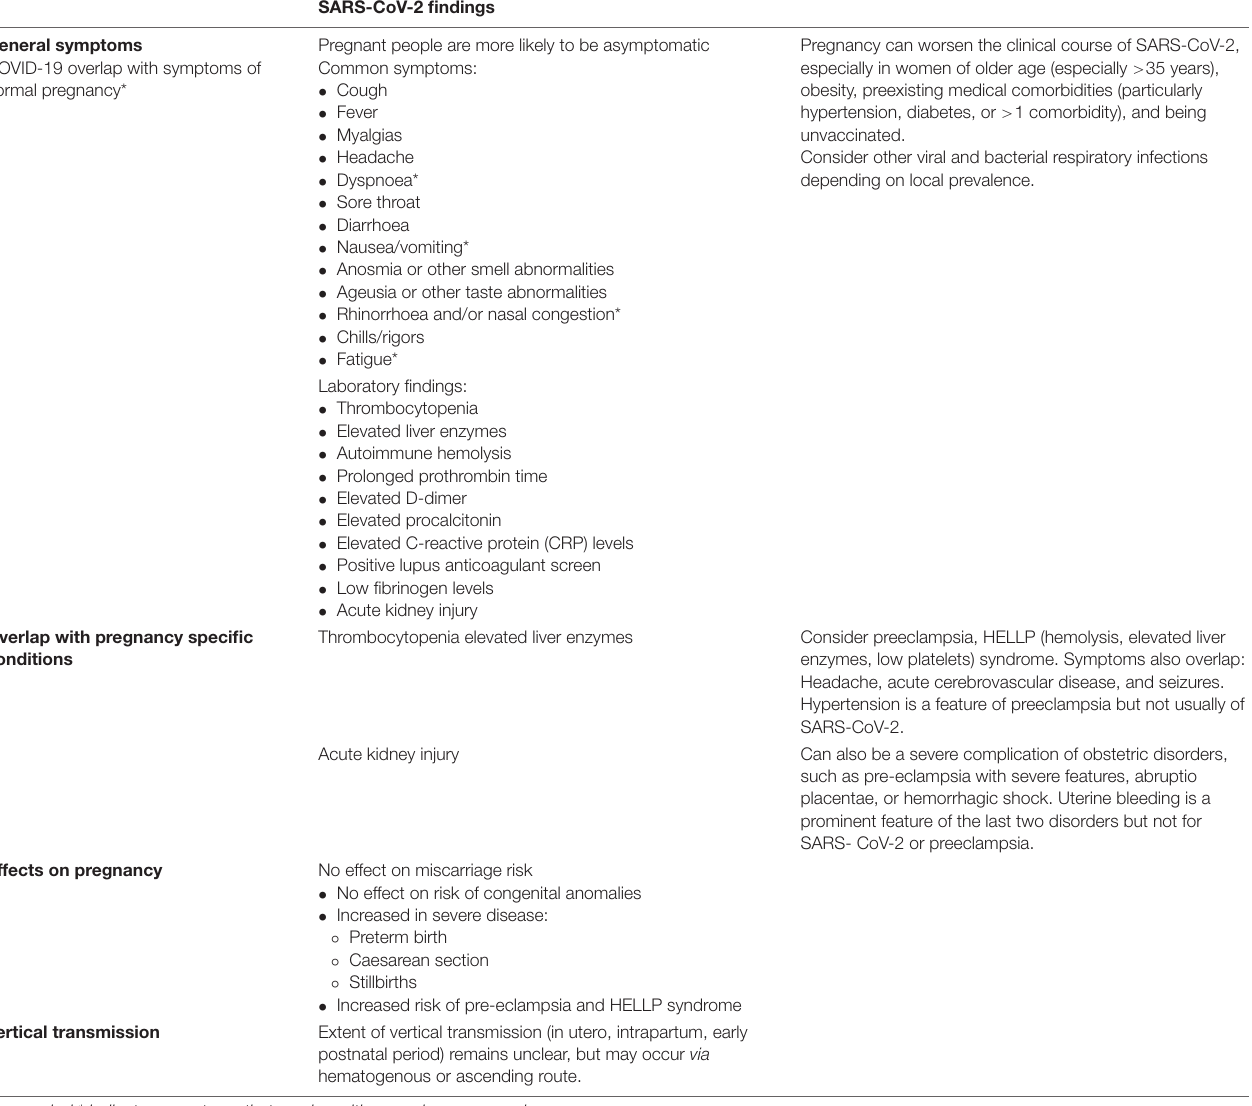
TABLE 4 | Pregnancy related complications of SARS-CoV-2 (Goldshtein et al., 2021, 2022; Shimabukuro et al., 2021; Morgan et al., 2022). SARS-CoV-2 findings Pregnant people are more likely to be asymptomatic General symptoms COVID-19 overlap with symptoms of Common normal pregnancy*